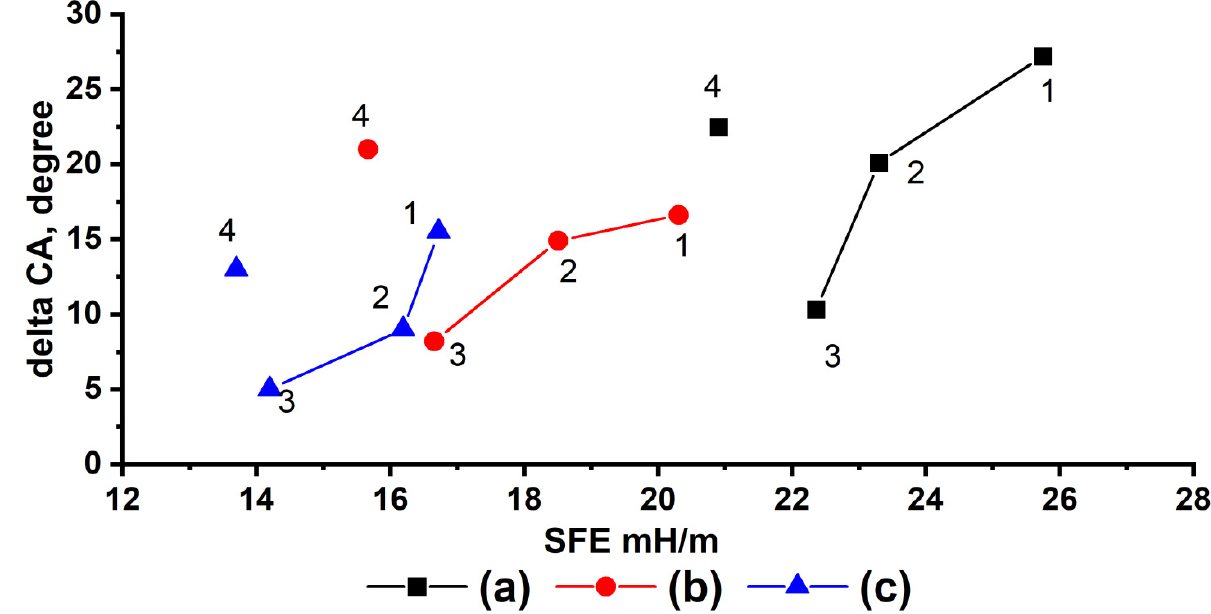
Figure 5. Dependence of the change of wetting angle after 24 h of contact of a water droplet with the textured aluminum surface modified with ( a ) poly-(TEMA-co-GMA); ( b ) textured aluminum surface modified with ( a ) poly-(TEMA-co-GMA); ( b ) poly-(HIMA-co-GMA); and poly-(HIMA-co-GMA); and ( c ) poly-(HBMA-co-GMA) from the surface free energy with varying ( c ) poly-(HBMA-co-GMA) from the surface free energy with varying FMA contents of the copolymer FMA contents of the copolymer (1—33%; 2—50%; 3—66%; 4—100%). (1—33%; 2—50%; 3—66%;